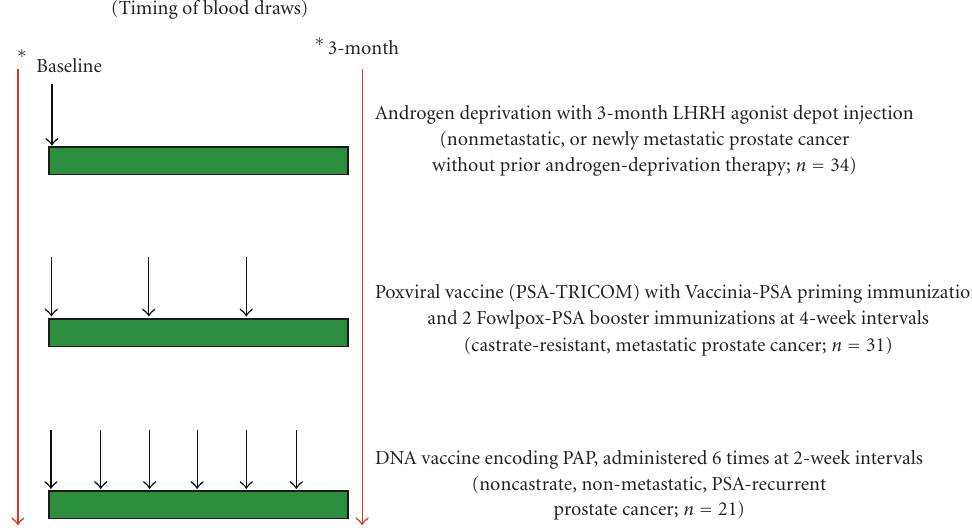
Figure 1: Schema for sample collection. Sera were collected from men with prostate cancer undergoing treatment on three separate clinical trials. Shown are the timing of blood collection and basic schema for these studies. In one study, blood was collected immediately preceding, and at three months following, standard androgen deprivation therapy with a 3-month depot injection of an LHRH agonist. Patients were men ( n = 34) with prostate cancer who had not previously received androgen depriving therapy, and had PSA-recurrent and/or metastatic prostate cancer. In the second study, blood was collected immediately preceding and three months following initiation of treatment with a poxviral vaccine encoding PSA (PSA-TRICOM) [5]. Patients were men ( n = 31) with castrate-resistant metastatic prostate cancer. In the third study, blood was collected immediately preceding, and at three months following, biweekly treatment with a DNA vaccine encoding prostatic acid phosphatase (PAP) [6]. Patients were men ( n = 21) with non-castrate, PSA-recurrent prostate cancer without evidence of metastatic